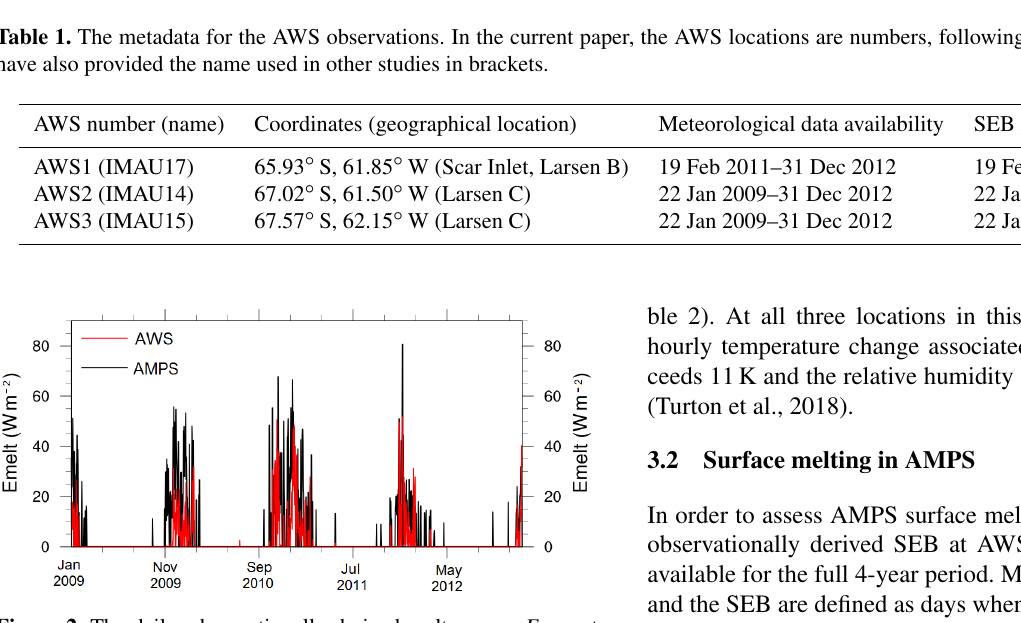
Figure 2. The daily, observationally derived melt energy E melt at AWS2 (red) and from AMPS (black) for